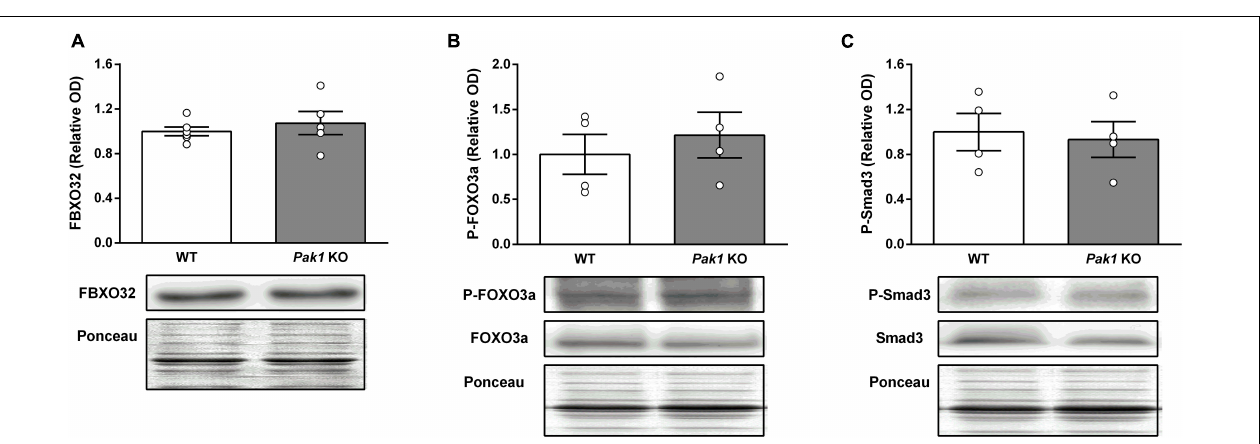
FIGURE 7 | Pak1 deletion does not increase Smad3 phosphorylation nor FBXO32 protein expression in skeletal muscle. (A) GC muscle FBXO32 protein levels, (B) P-FOXO3a, and (C) P-Smad3 levels in GC muscles from Pak1 KO and WT mice ( n = 4–6/group). The results are expressed as mean ± SEM. Statistical analysis was performed using unpaired t -test to compare results from Pak1 KO and WT